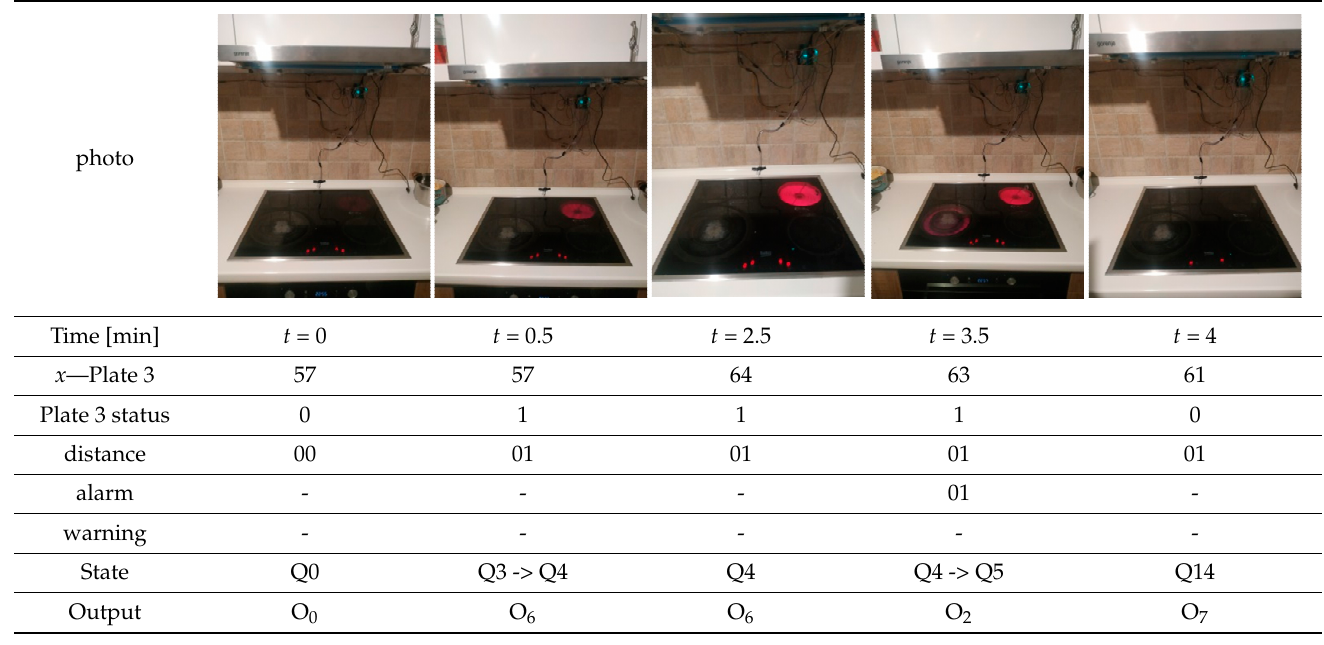
Table 6. Analysis of the results for test Scenario 3: Plate 3.